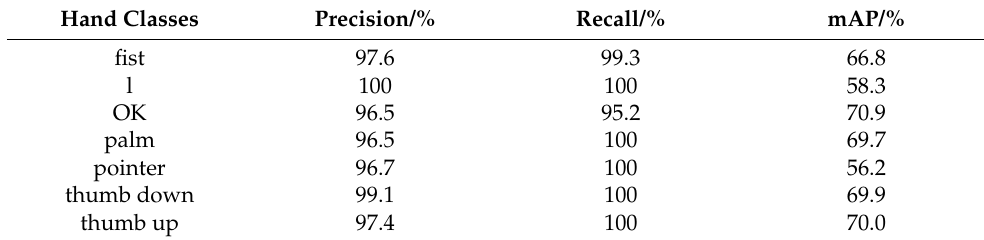
Table 4. Each gesture recognition result with the TinyHGR